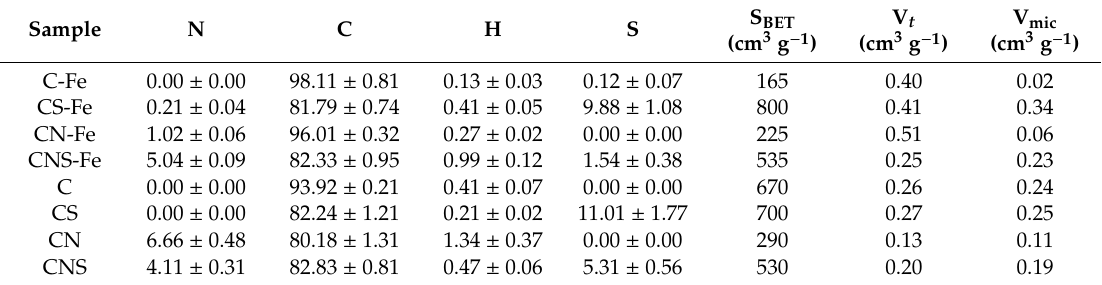
Table 1. Elemental composition (wt.%) and textural parameters of the studied carbon samples. Sample